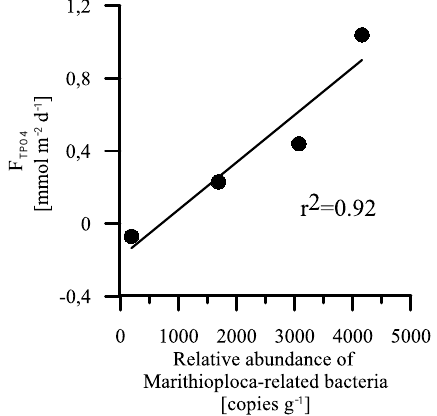
Figure 6. Measured TPO 4 fluxes vs. relative abundance of Marithioploca in cellsg − 1 in the upper 5cm of the sediment. High- est abundance and TPO 4 flux were found at station I. The other data points are for stations IV, VI, and VIII (with decreasing abundance and TPO 4